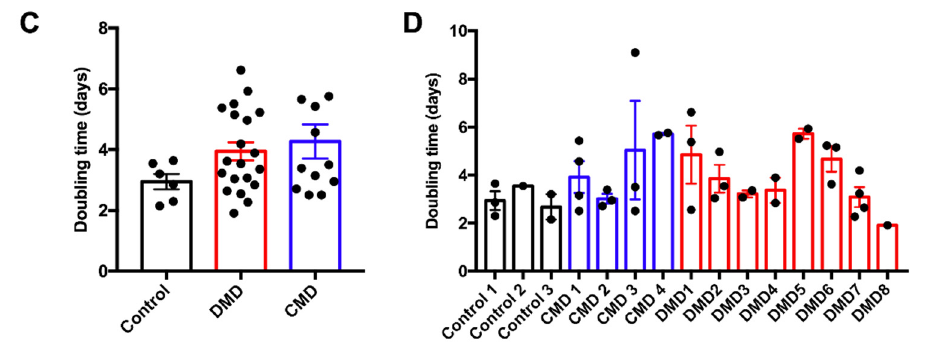
Figure 1. Growth curve of immortalized human muscle stem cell (iHMuSC) clones. IHMuSC clones were expanded in growing medium. ( A ) Growth of eight clones from eight different patients. ( B ) Growth of three different clones from the same patient (one control and one DMD patient are shown). ( C ) Population doubling time of control, DMD (Duchenne Muscular Dystrophy) and CMD (Congenital Muscular Dystrophy) derived iHMuSCs. ( D ) Comparison of population doubling time from each donor (clones from the same donor are gathered in one bar). Statistical analyses were done using one-way ANOVA.